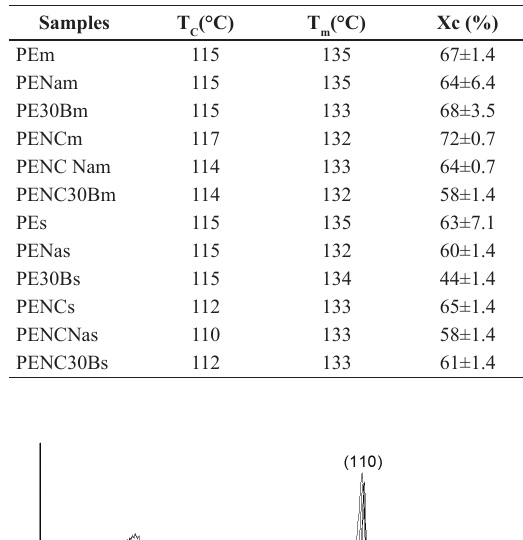
Table 2. DSC result of PE and nancomposites for different mixing